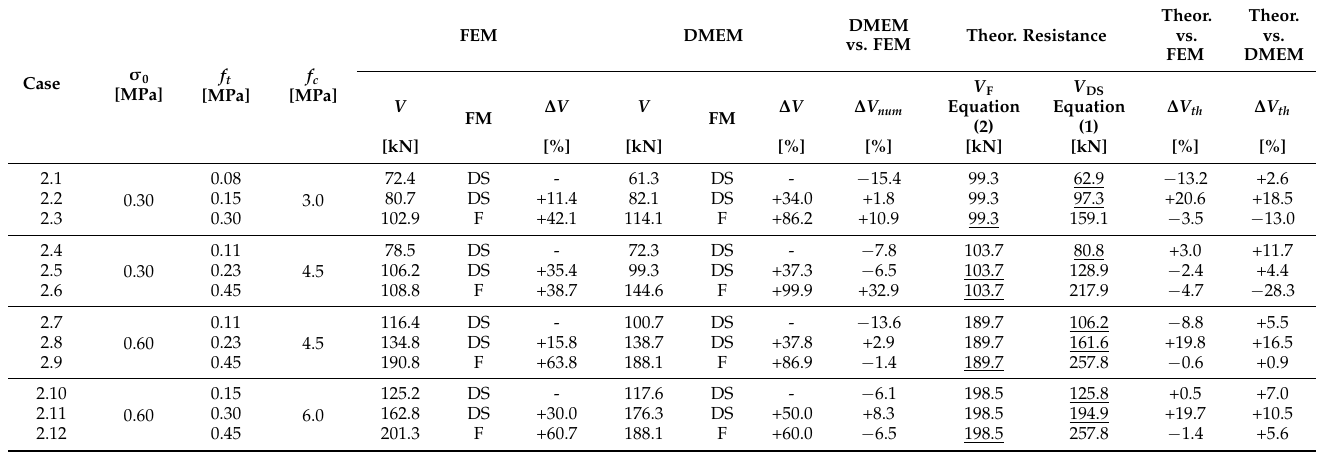
Table 8. Shear resistances of Group